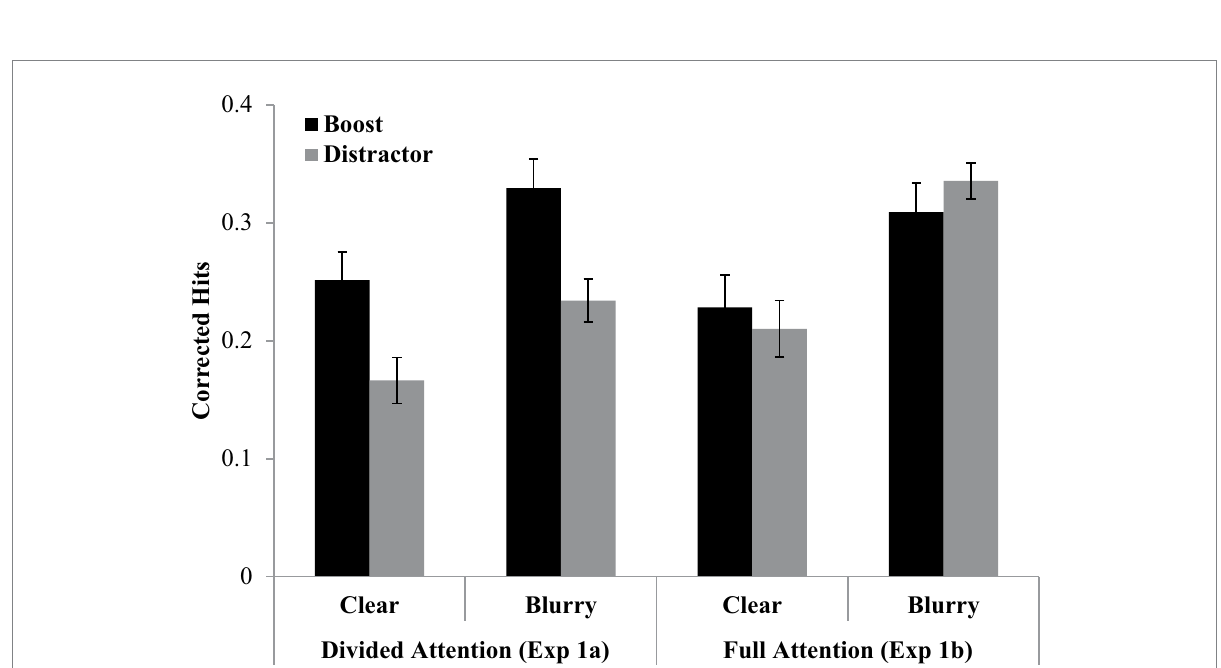
FIGURE 2 Mean corrected hits (hits minus false alarms) for each condition for both Experiment 1a, in which the task involved word reading and signal monitoring, and Experiment 1b, in which the task involved only word reading. Error bars reflect standard errors corrected to remove overall between-subject variation (Morey, 2008).